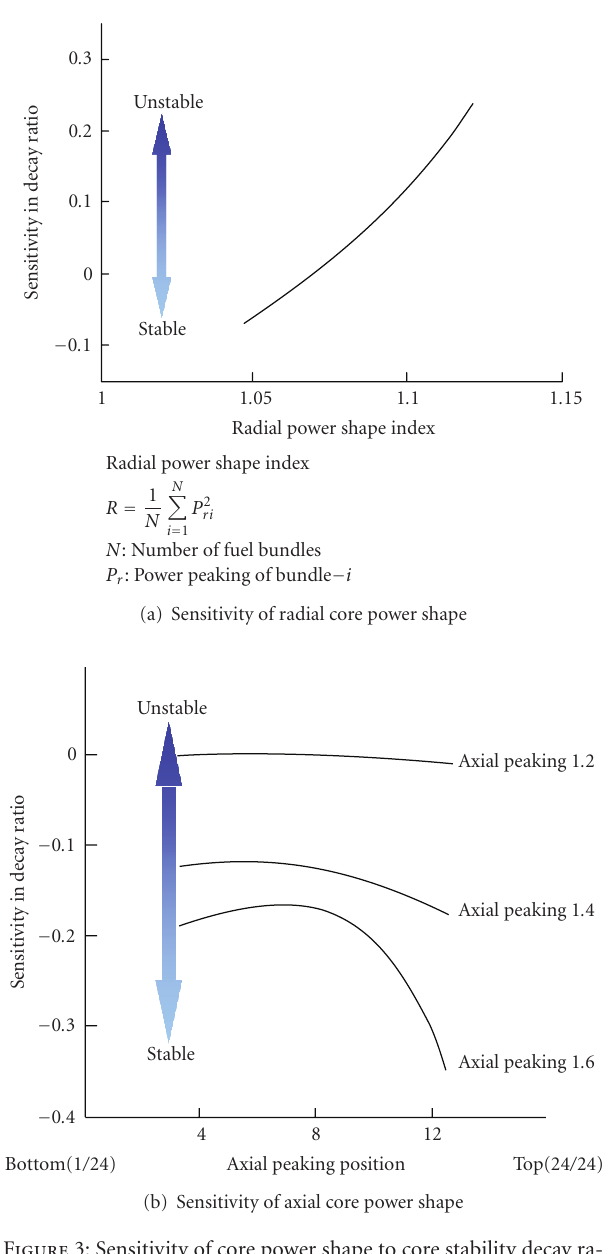
Figure 3: Sensitivity of core power shape to core stability decay ra-